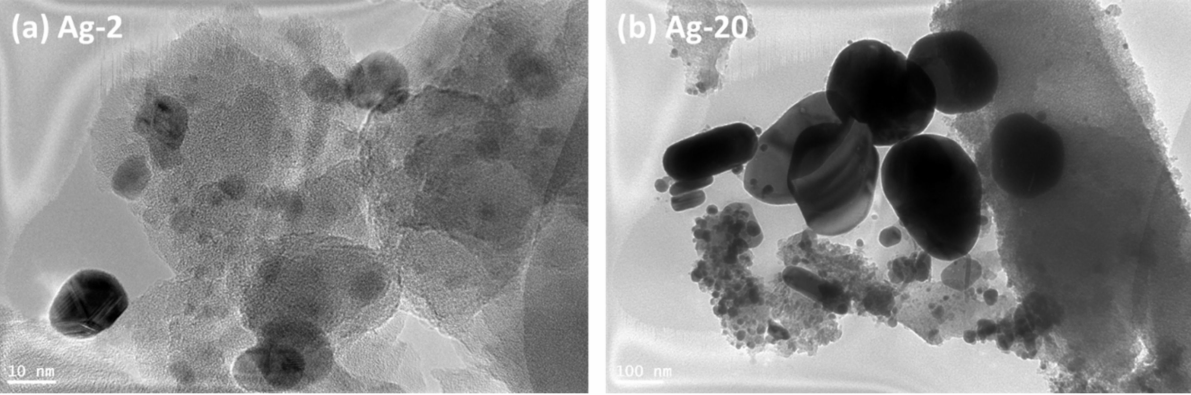
Figure 4. The HR-TEM micrographs of Ag-2 and Ag-20